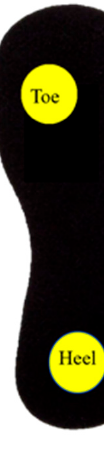
Figure 8. The position of the sensors on the heel and toe part of the insole which are related to the point with higher pressure in the sole of the foot. Table 1. Response of the force platform and POF sensor at heel and toe.